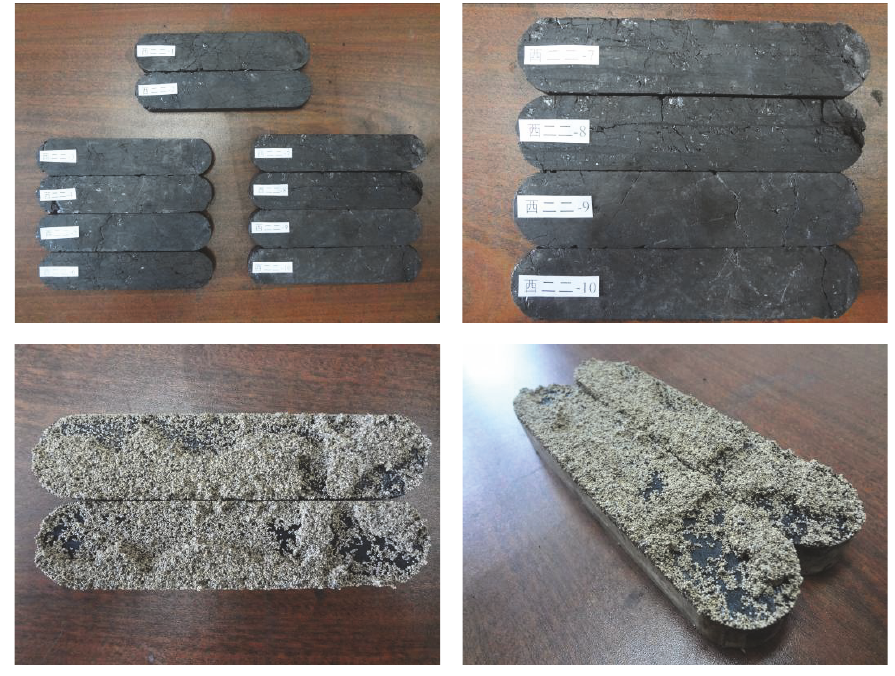
Figure 6: Coal plate shape before and after fracture conductivity test.